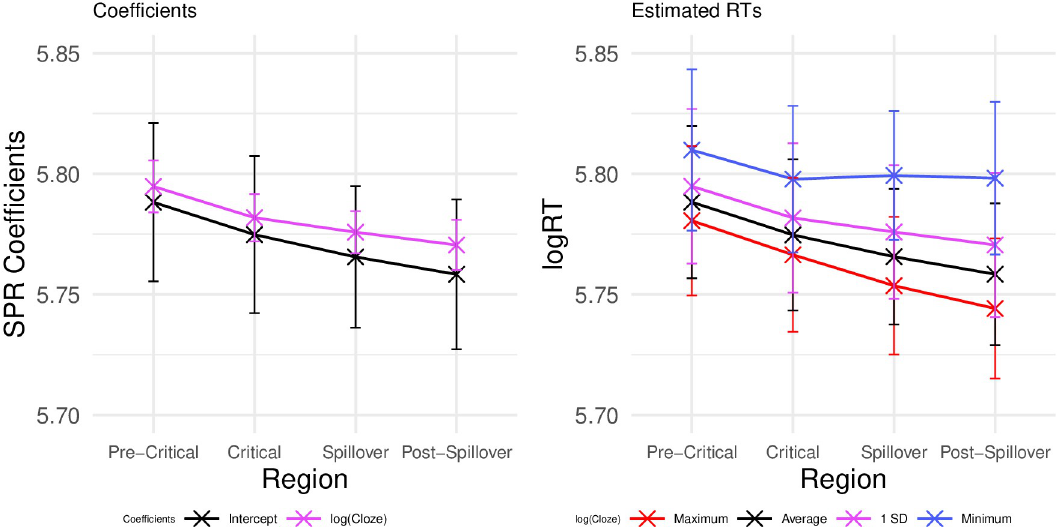
Fig 11. Exploratory RT analysis. Coefficients (left; added to their intercept) and estimated log-RTs (right) for exploratory LMER models fitted only on Condition A. Error bars indicate the standard error on the coefficients from the statistical model (right) and standard error computed from the per-subject per-value